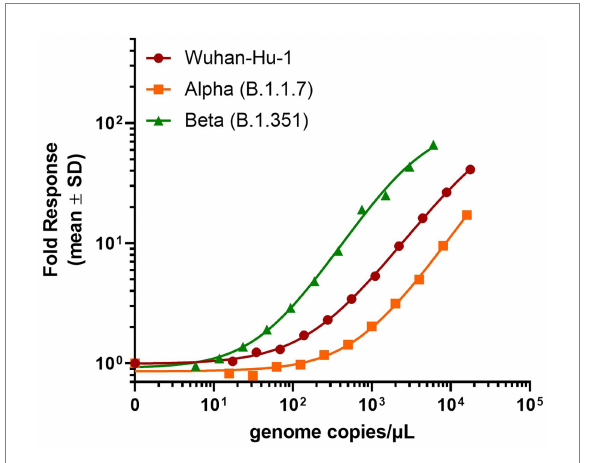
FIGURE 3 Detection of SARS-CoV-2 heat-inactivated viruses with N-antigen assay. 30 ng/ml β 9-labeled anti-SARS-CoV-2 N mAb Cat. 9,547, 60 ng/ml β 10-labeled anti-SARS-CoV-2 N mAb